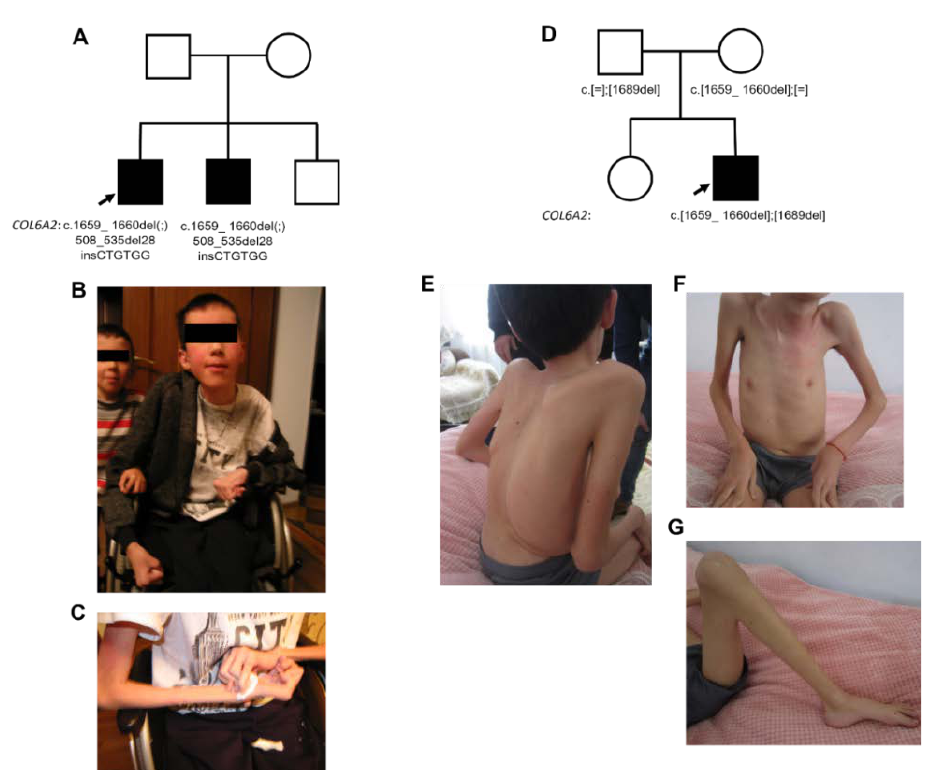
Figure 1. The pedigree of the first family ( A ) and clinical presentation of the first proband: the patient is non-ambulatory ( B ), contractures of the wrist and elbow joints, and prominent diffuse atrophy of upper limb muscles ( B , C ). The second family pedigree ( D ) and the clinical presentation of the second proband: diffuse muscle atrophy ( E – G ), prominent kyphoscoliosis with asymmetrical chest deformity ( E , F ), flexion contractures of the large joints ( F , G ). The patient has two male siblings, and one of them is similarly affected (Figure 1B).